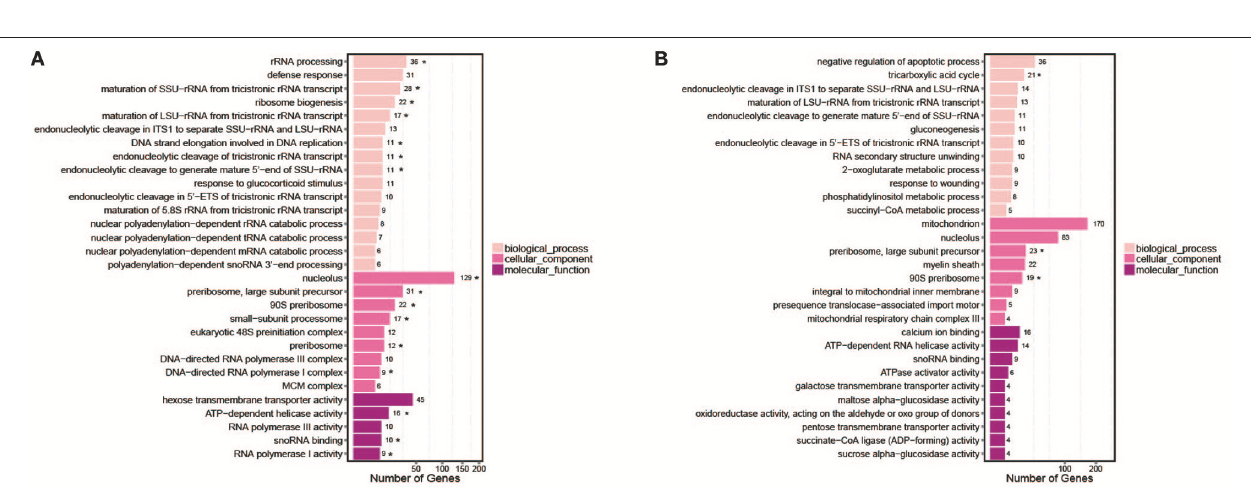
FIGURE 6 | Scatter plot of top 20 enriched KEGG pathways for genes with significant expression levels in two endophytic fungi (A) P. polonicum hy4 (B) C. gloeosporioides Cg01. A high Q -value is represented by blue and a low Q -value is represented by red. Bubble size indicates DEG number (increases with DEG number).